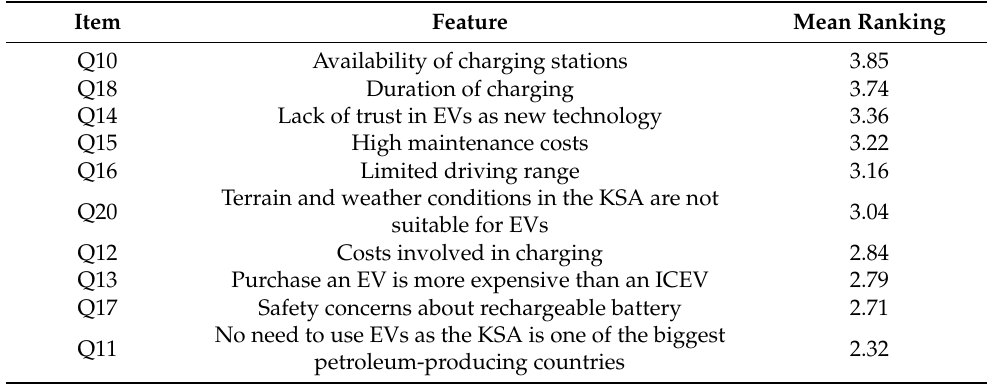
Table 8. Mean ranking of